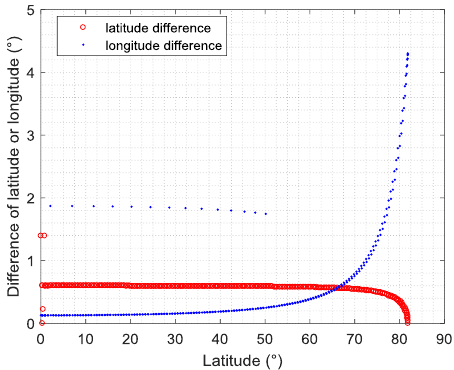
Figure A1. Relationship curves of the latitude and longitude differences for the two nearest pixels with latitudes, where circles are for the latitude differences, and points are for the longitude differences.